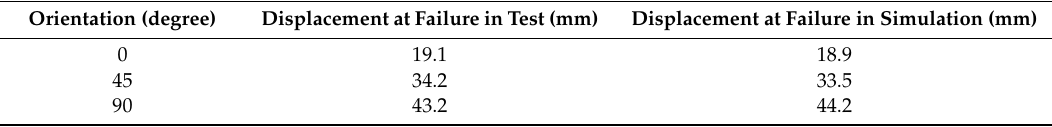
Figure 13. Validation FE model, using orthotropic shells at the initial time ( left ) and results just before the end (displacement = 40 mm) of the simulation ( right ), at which point two of the three specimens have already reached the failure limit. Table 3. Failure displacement results in test and